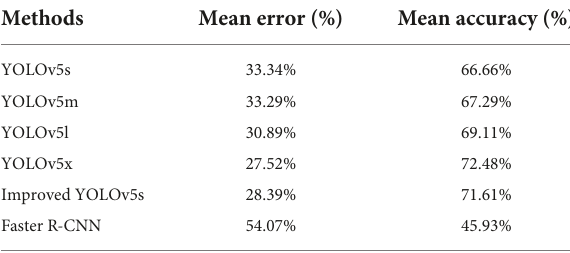
TABLE 3 Statistical average error and average